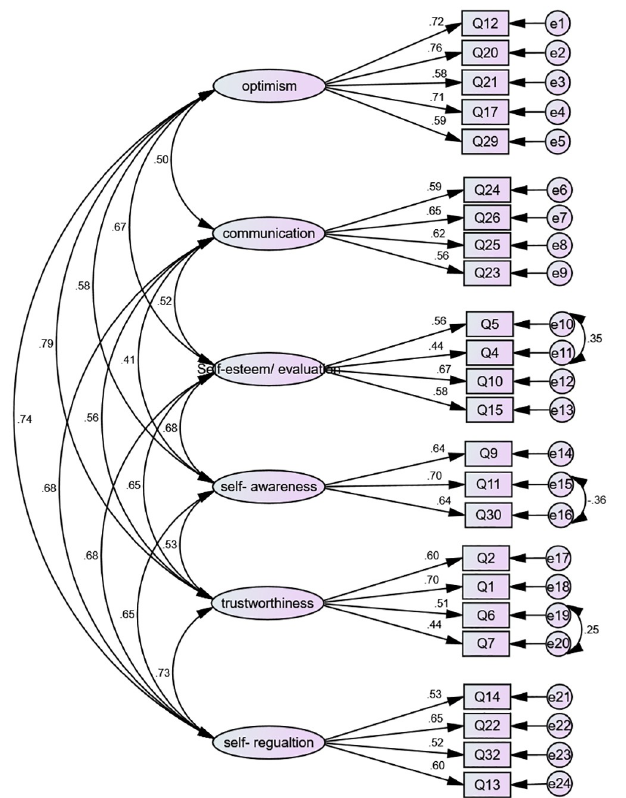
Fig 1. The first-order factor analysis of the